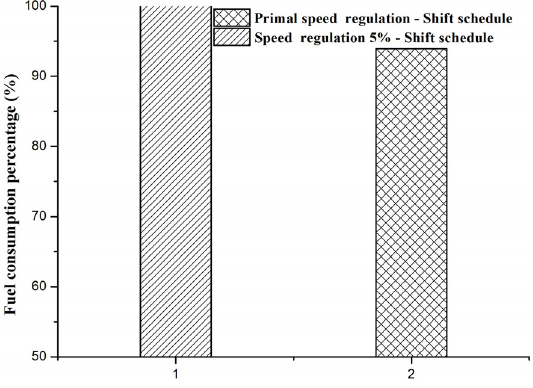
Figure 16. Fuel consumption percentage of real vehicle confirmatory experiment in the complex driving